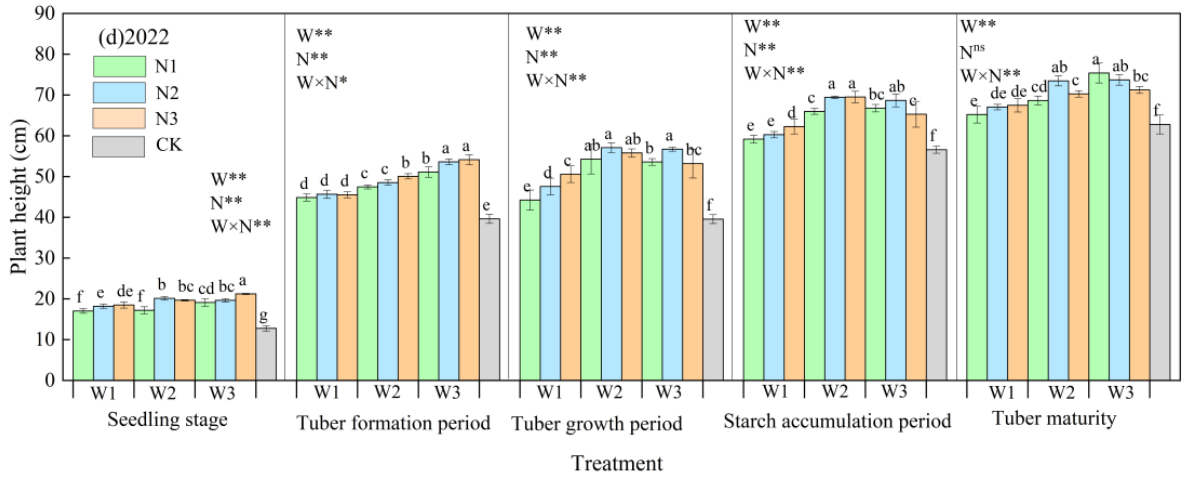
Figure 4. Effects of water and nitrogen regulation on potato growth. Note: ( a ) is potato plant stem thickness in 2021, ( b ) is potato plant stem thickness in 2022, ( c ) is potato plant height in 2021 and ( d ) is potato plant height in 2022. * and ** indicate p < 0.05 and p < 0.01, respectively; ns indicates that there was no significant effect ( p > 0.05). N is the nitrogen application rate, and W is the irrigation